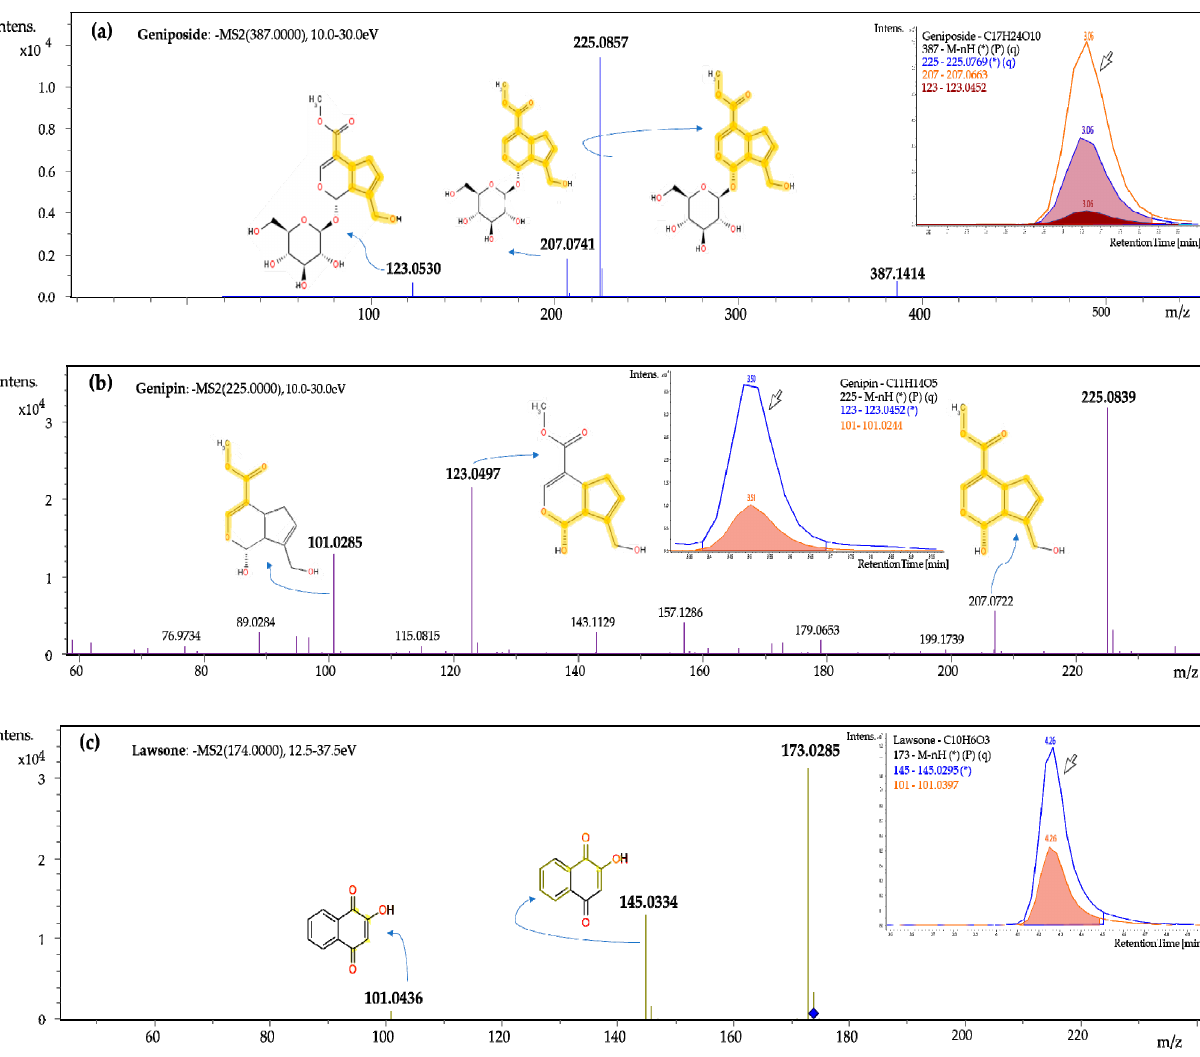
Figure 1. Chromatographic peak and mass spectra of the targeted compounds: ( a ) Geniposide, ( b ) Genipin, ( c ) Lawsone. The method was validated in terms of linearity and precision. Limits of detection (LODs) and quantification (LOQs) were also calculated. The results are depicted in Table 2. Calibration curves were obtained covering a concentration range of 0.1 to 2.5 μ g·mL − 1 with standards (genipin and geniposide) prepared in methanol and with seven concen- tration levels and three replicates at each level. For lawsone, they were obtained in a range of 0.25 to 2.5 μ g·mL − 1 , with six concentration levels. The method exhibited a direct proportional relationship between the amount of each analyte and its chromatographic response, with coefficients of determination (R 2 ) higher than 0.990 in all cases. The in- strumental method precision was evaluated (n = 3) for all the calibration concentration levels showing mean relative standard deviation (RSD) values lower than 5%. Mean RSD values are shown in Table 2. The LODs and LOQs were calculated as the compound